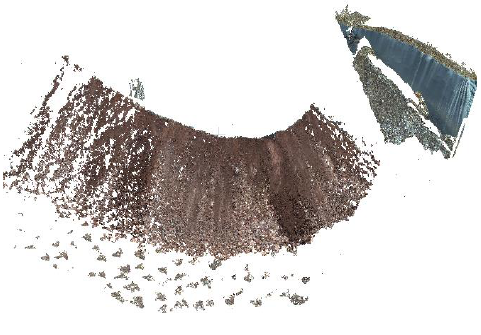
Fig.6 TLS point cloud of study